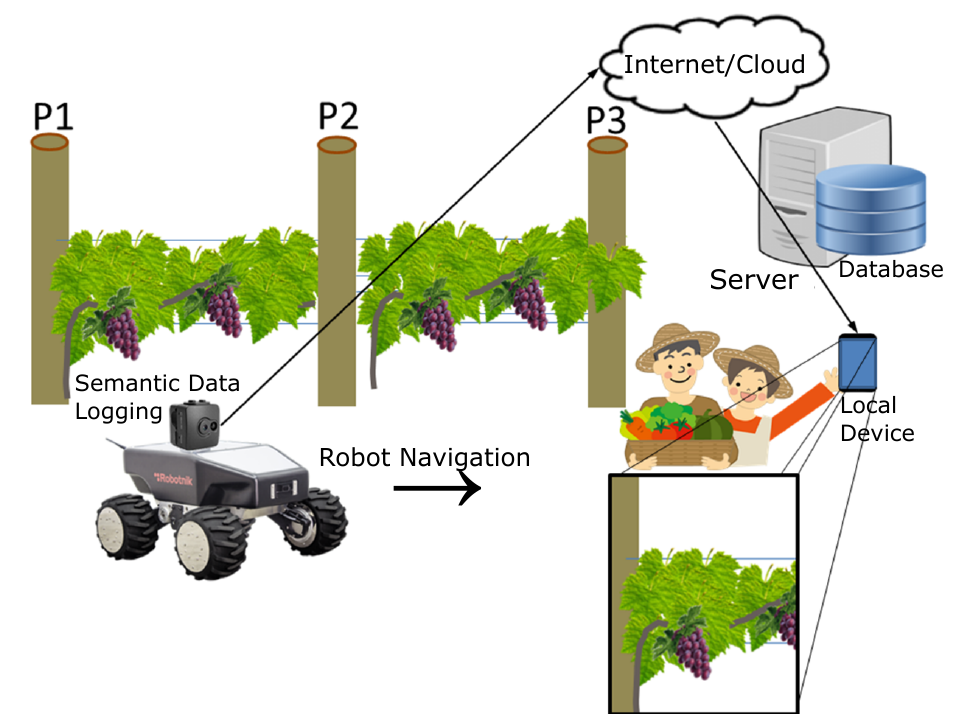
Figure 1. Overview of the proposed semantic monitoring